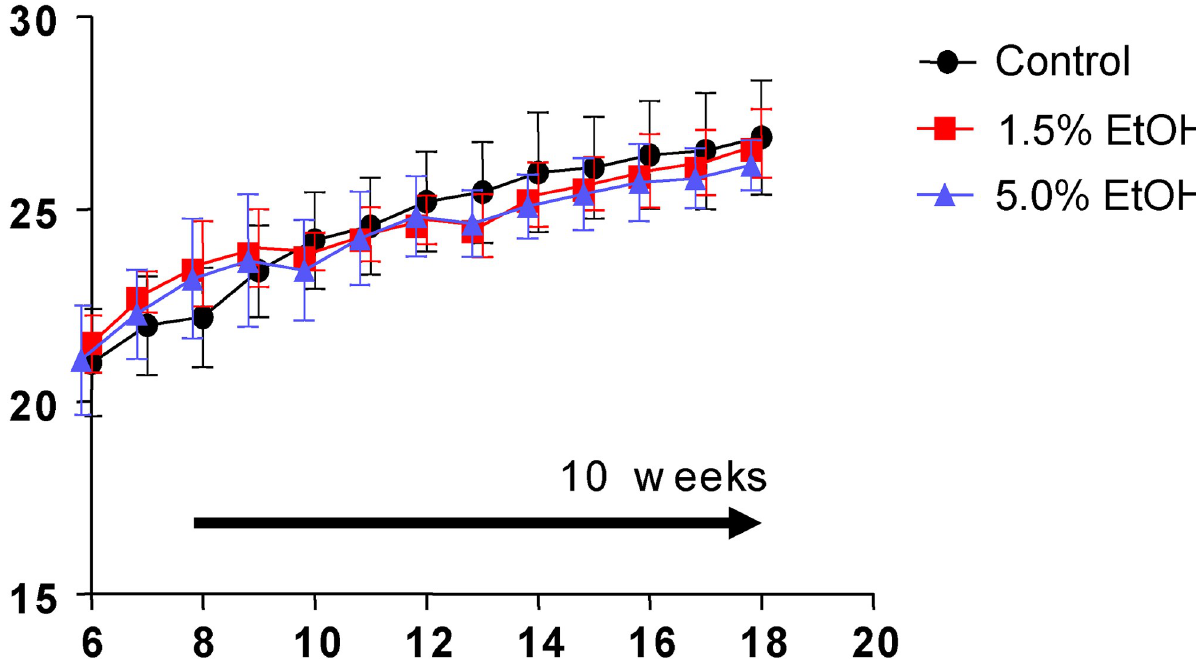
Fig 1. Course of body weight changes during the experiment. Eight-week-old mice were orally gavaged daily with 1.0 mL/day of water (control, black circles), 1.0 mL/day of 1.5% (v/v) ethanol (the 1.5%-ethanol group, red squares), and 1.0 mL/day of 5.0% (v/v) ethanol (the 5.0%-ethanol group, blue triangles) for 10 weeks (horizontal arrow). Body weights were measured every week. The data are expressed as means ± SD (n = 7 to 8) for each group and assessed using ANOVA with the Tukey-Kramer test.